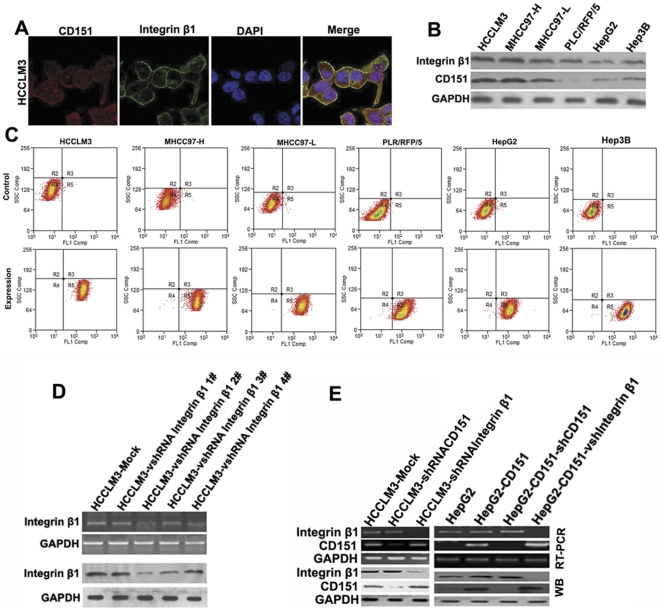
Location and expression of CD151/integrin β1 complex in HCC cells.An immunofluorescence assay was performed. CD151 was stained with red and integrin β1 was stain with green. CD151 and integrin β1 co-localized on the plasma membrane in HCCLM3 cells (A). Western blotting revealed that the expression of CD151 in high metastatic HCCLM3 cells was highest and non-metastatic HepG2 cells presented the lowest levels of CD151 among six HCC cells. The results also demonstrated high expression of integrin β1 in six HCC cells lines (B). Flow cytometry analysis showed that the high proportion of integrin β1-positive cells were in six HCC cells (C). After transfection, HCCLM3-shRNA 2# was most efficient in downregulating the expression of integrin β1 at both the protein and mRNA levels (D). The level of integrin β1 expression remained unchanged in HCC interfered with CD151 shRNA, and vice versa (E).